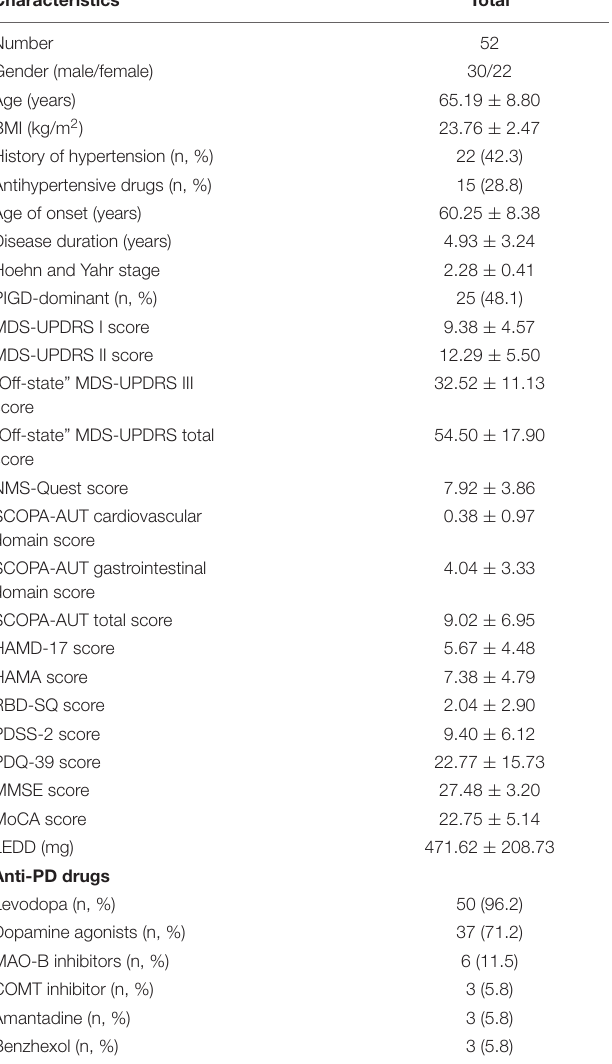
TABLE 1 | Demographic and clinical characteristics of patients with PD.